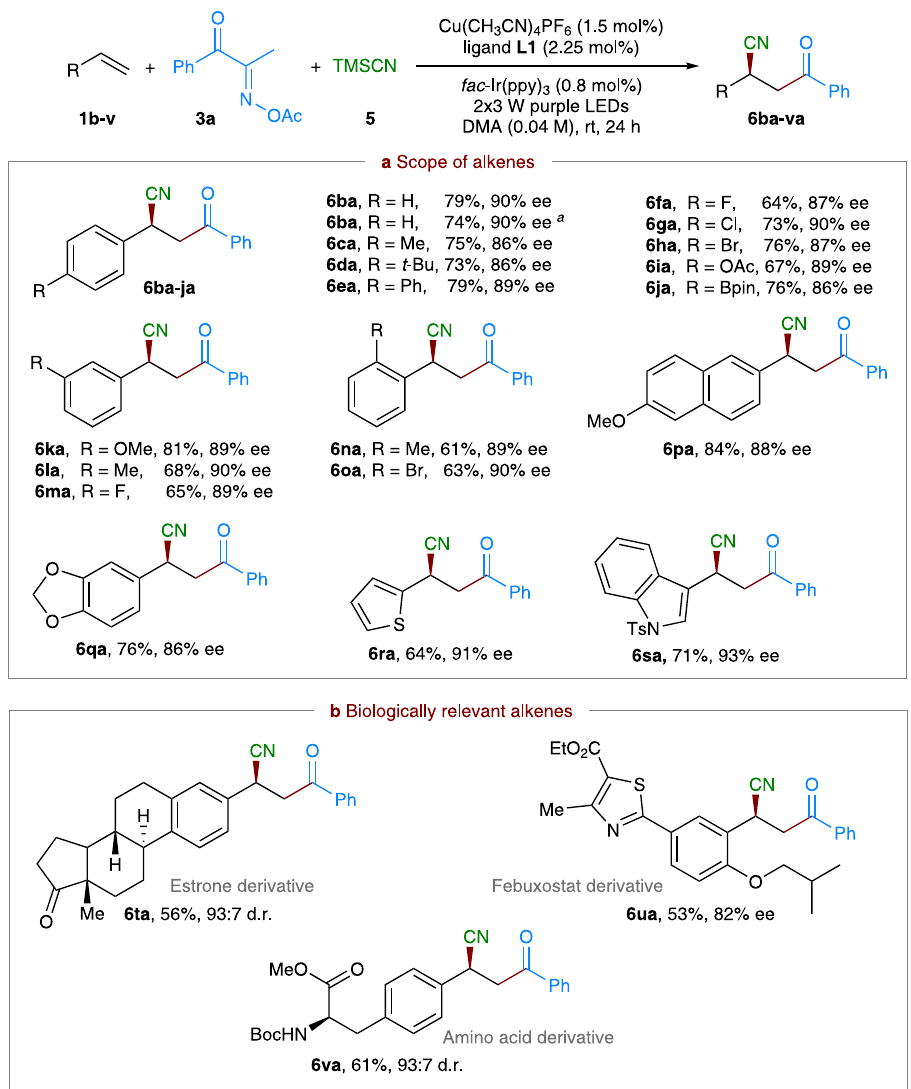
Fig. 3 Scope of the alkenes in asymmetric three-component alkene acylcyanation. Reaction conditions: 1 (0.1 mmol), 3a (0.3 mmol), TMSCN (0.3 mmol), Cu(CH 3 CN) 4 PF 6 (1.5 mol%), ligand L1 (2.25 mol%), fac -Ir(ppy) 3 (0.8 mol%), DMA (2.5 mL), 2 × 3 W purple LEDs, at room temperature. Isolated yields were reported. The ee and d.r. values were determined by HPLC analysis on a chiral stationary phase. a 1.0 mmol scale reaction, 24 h. a Scope of alkenes. b Biologically